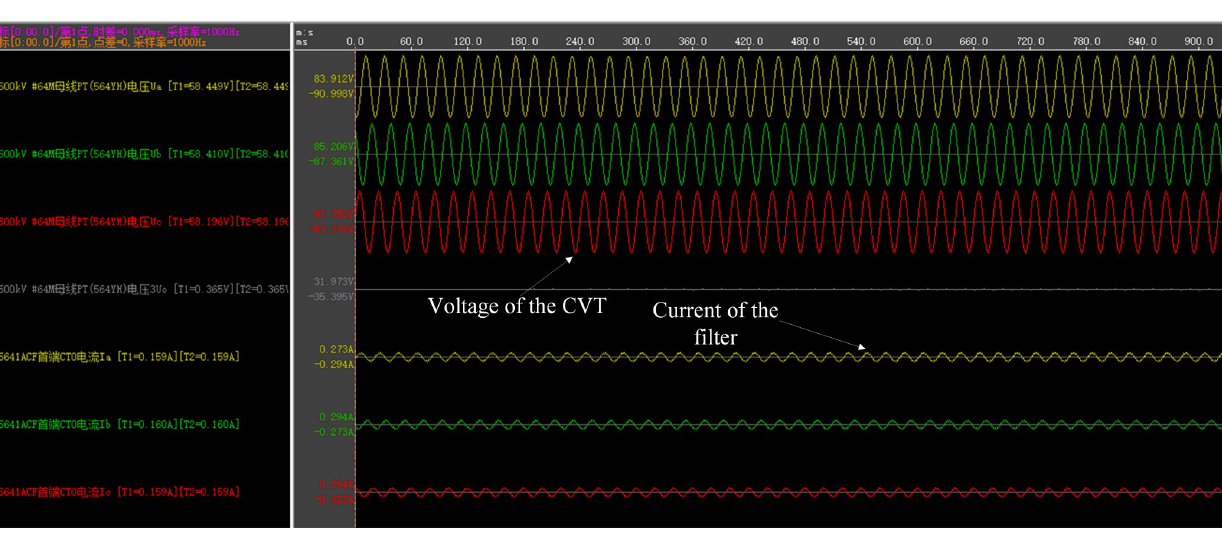
Fig 16. The waveforms of the filter currents and CVT